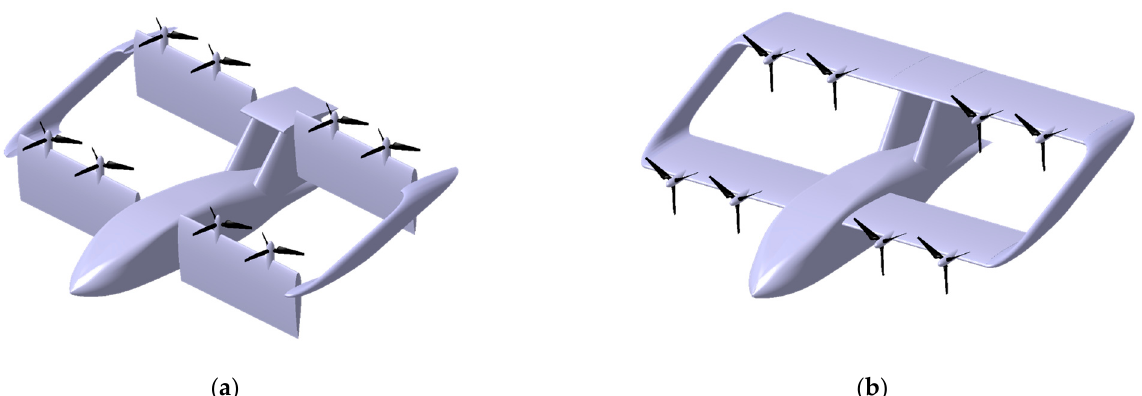
Figure 3. Artistic views of the TiltOne : ( a ) hovering and vertical flight mode (or “multi-rotor” mode); ( b ) horizontal flight mode (or “fixed-wing” mode).